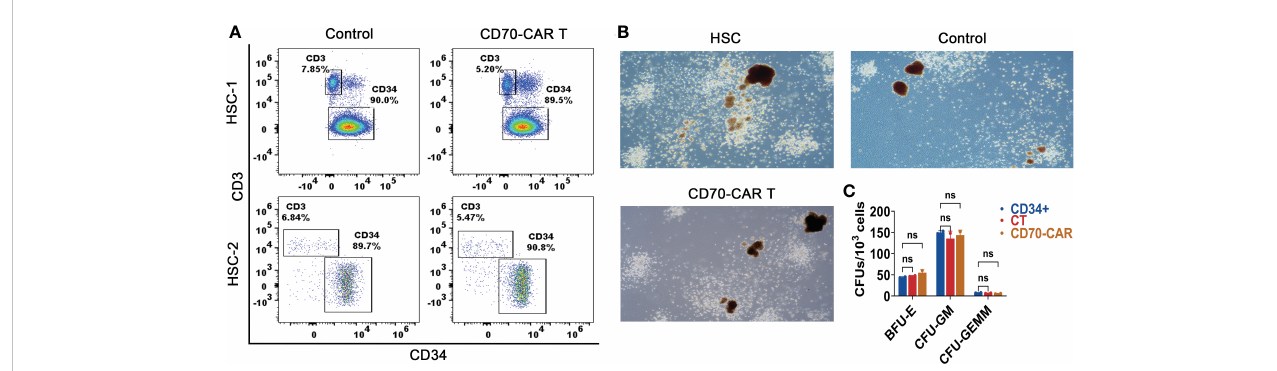
FIGURE 3 Anti-CD70 CAR-T cells did not impair normal HSCs. (A) , CD34 + cells were co-cultured with CAR-T or control T cells at an E:T ratio of 1:10 for 4 h, and then were analyzed for determining the frequencies of CD34 + and CD3 + cells. (B) , The cells obtained above co-culture system and methylcellulose were transferred into culture dishes for 14 days incubation. Representative images of colonies observed under the microscope (C) , The burst-forming unit- erythroid (BFU-E), colony-forming unit-granulocyte, macrophage (CFU-GM) and colony-forming unit-granulocyte, erythroid, macrophage (CFU-GEMM) counts were performed under a microscope. Data show the results of three independent experiment. One-way ANOVA analysis; ns means no signi fi